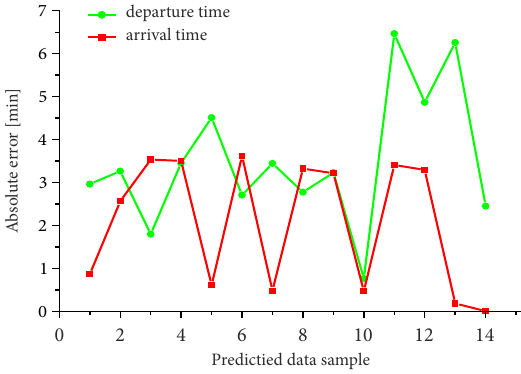
Figure 7. Absolute error of the BP neural network prediction Table 6. Comparison of the travel-time prediction results